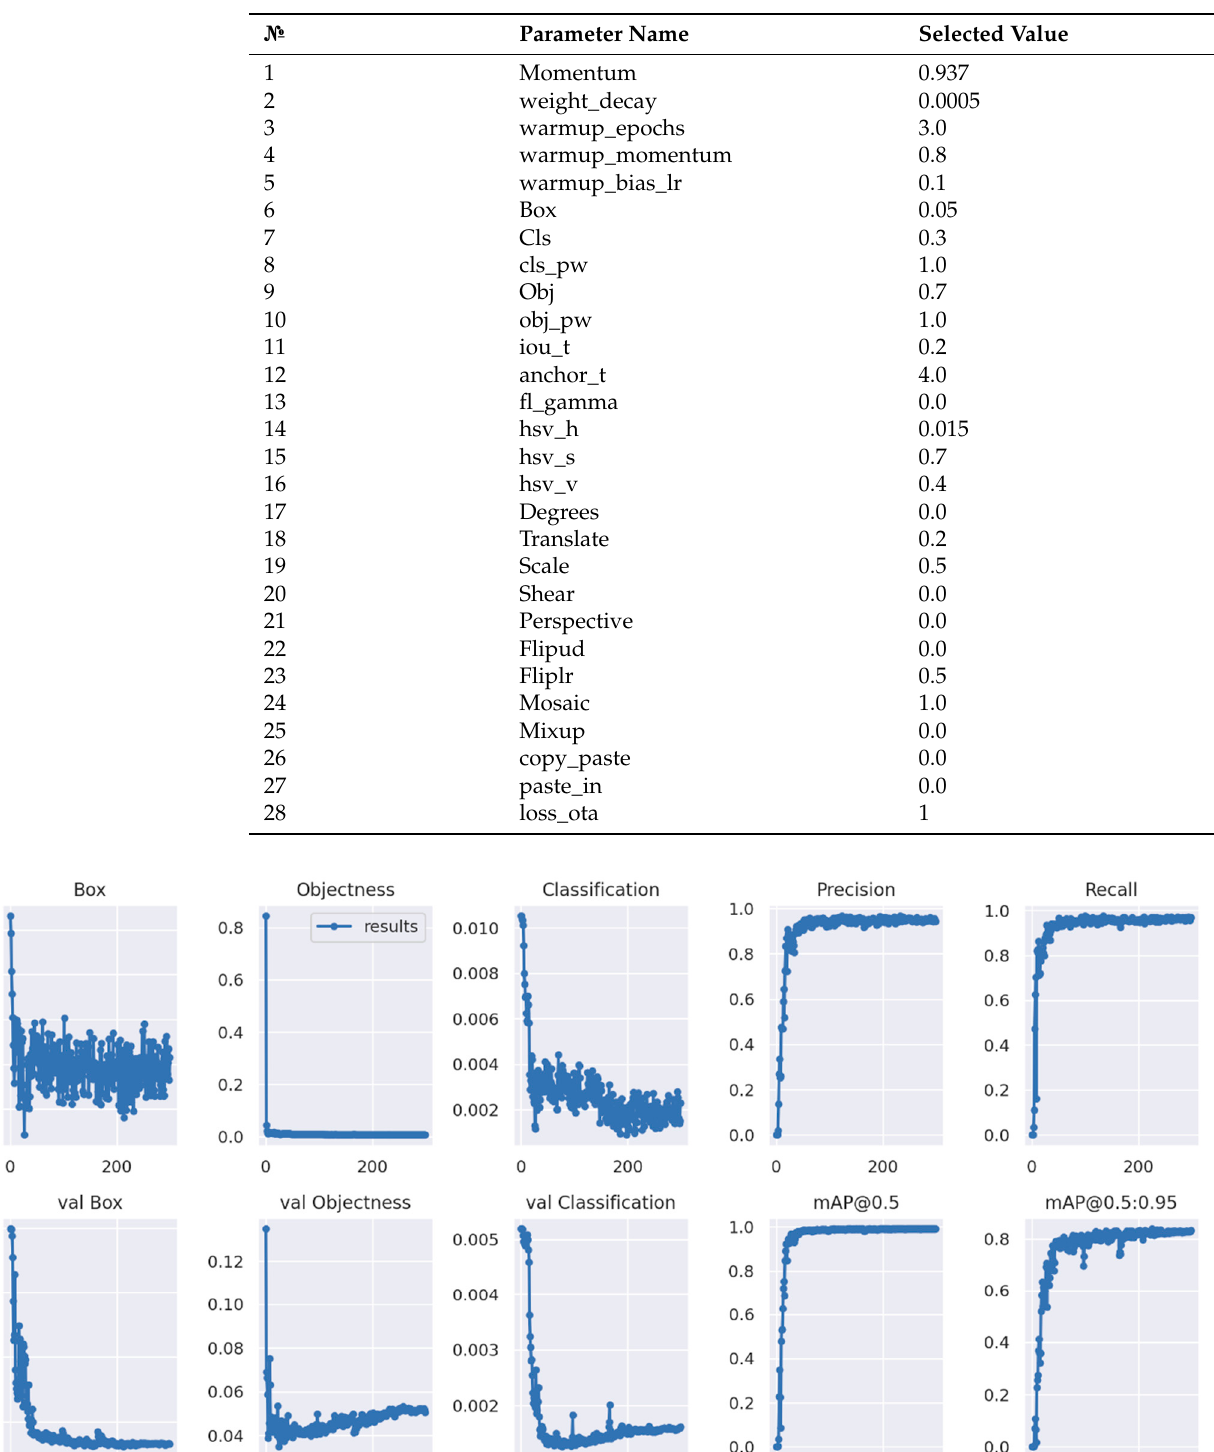
Table 2. The YOLOv7 training hyperparameters.